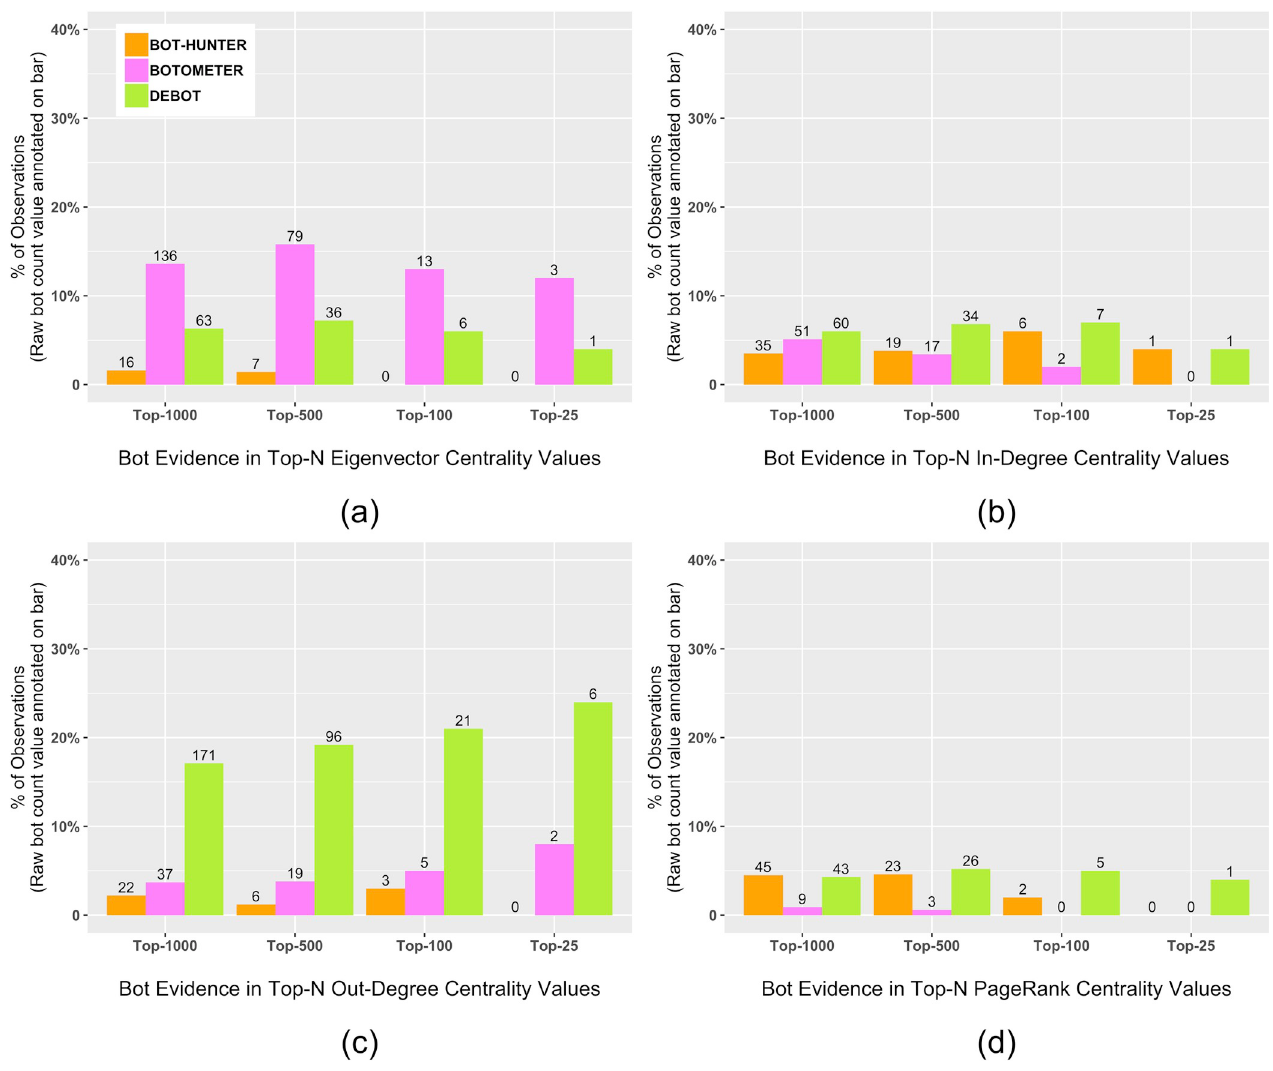
Fig 5. Social bot account evidence within the top-N (where, N = 1000 / 500 / 100 / 25) centrality rankings [(a) eigenvector (b) in-degree (c) out-degree (d) PageRank] according to bot classification results from Bot-hunter (orange), Botometer (pink) and DeBot